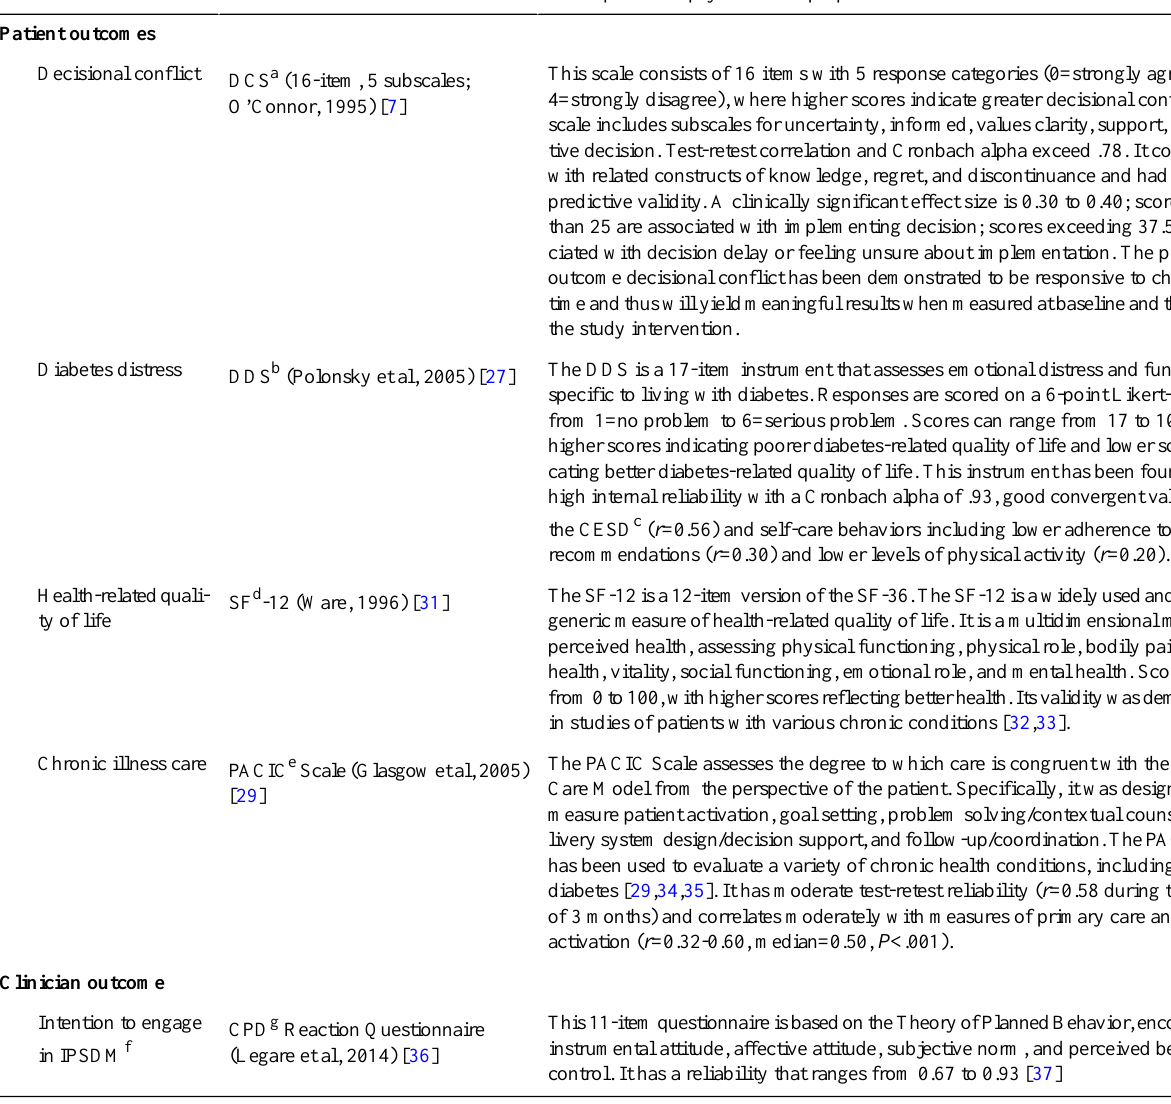
Description and psychometric